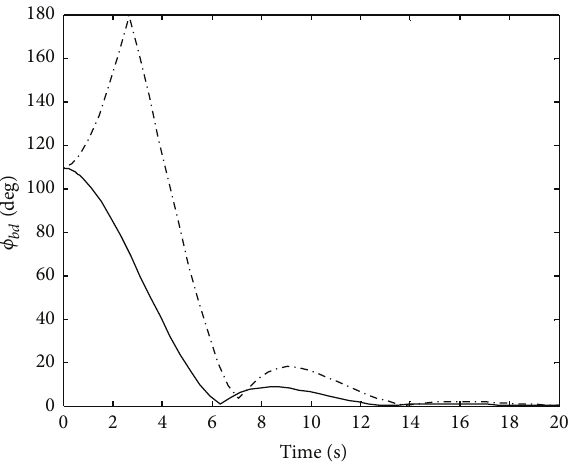
Figure 1: Euler angle response, 𝜙 𝑏𝑑 ; Theorem 3 (solid line) and PD- like control law (dash-dot